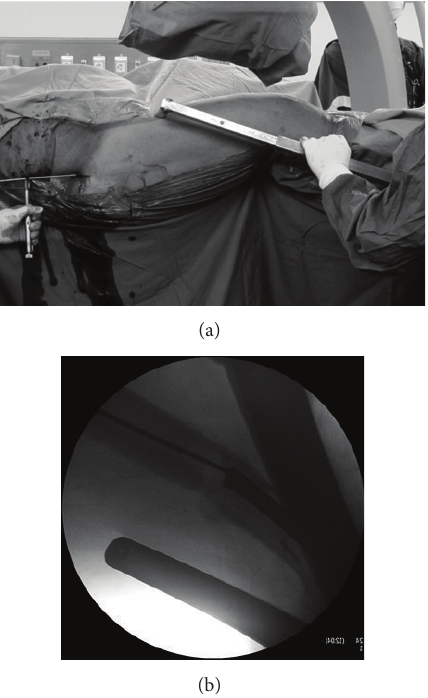
Figure 3: (a) The fracture is closely reduced by using the F- shaped reduction clamp and (b) reduction is maintained by an intramedullary guide wire.